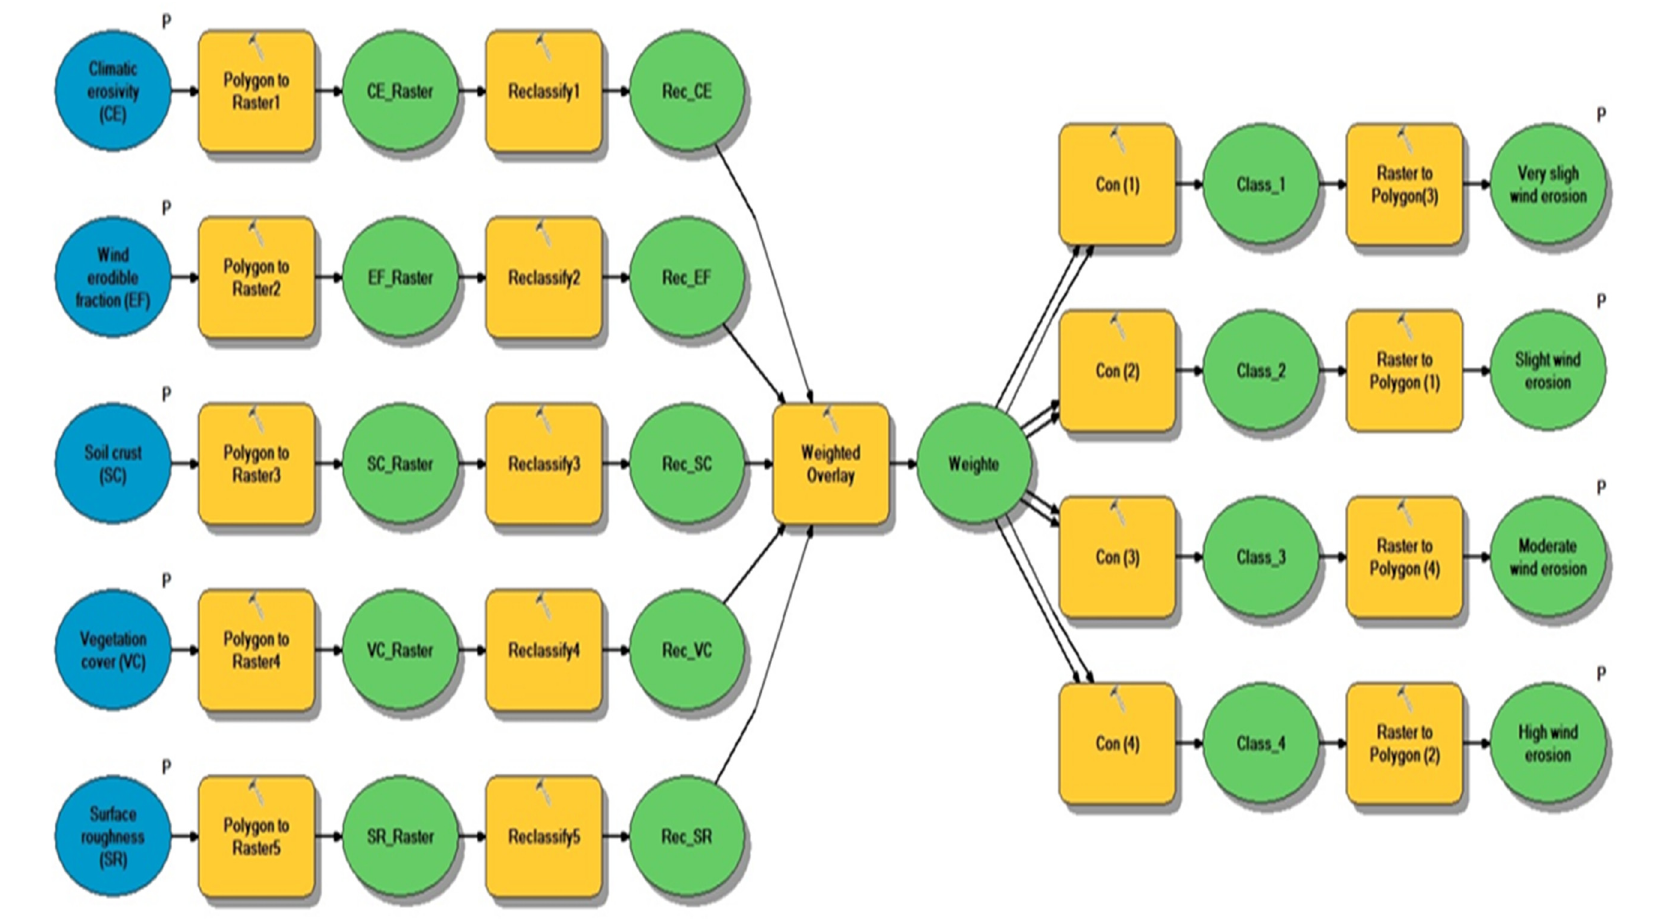
Figure 5. A flowchart of the proposed spatial-based model (SSLM) design steps according to the ILSWE model.